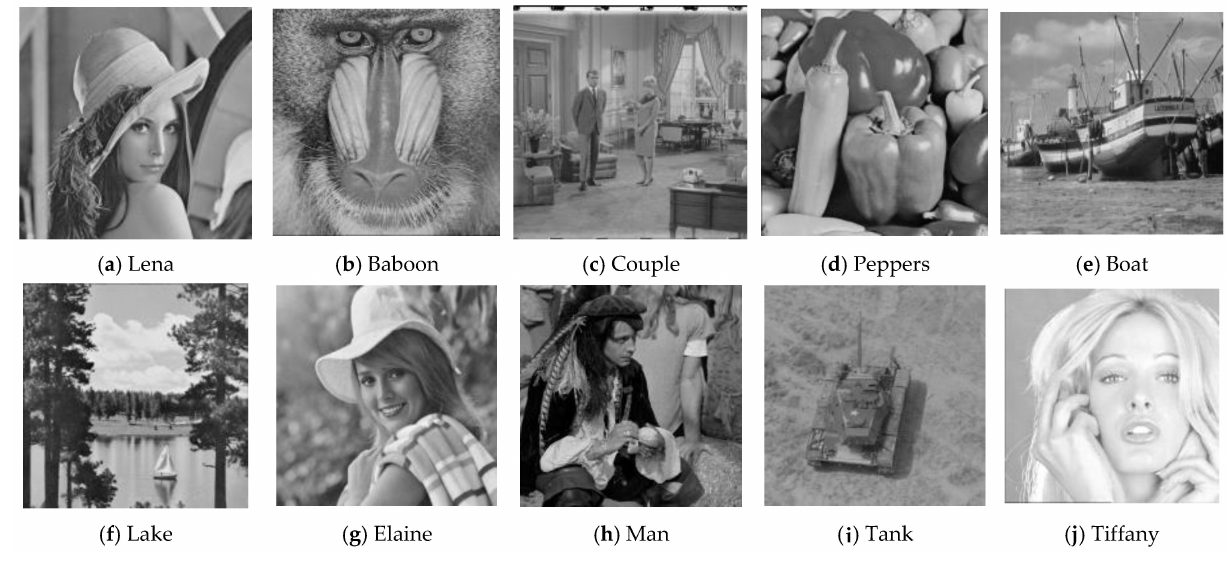
Figure 2. Ten typical test images.